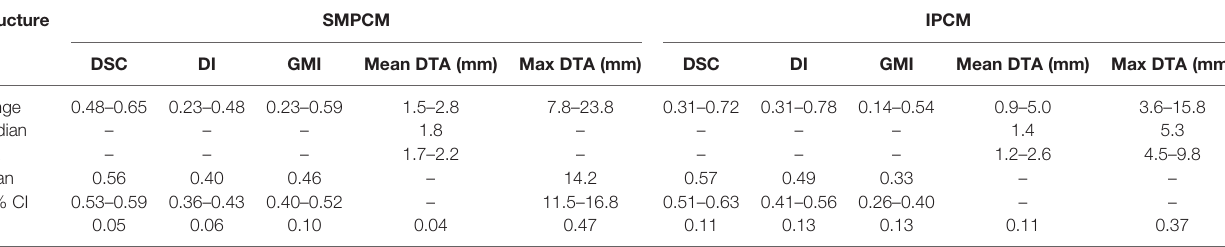
TABLE 1 | Values for different conformity indices for superior and middle pharyngeal constrictor muscle (SMPCM) and inferior pharyngeal constrictor muscle (IPCM). Structure